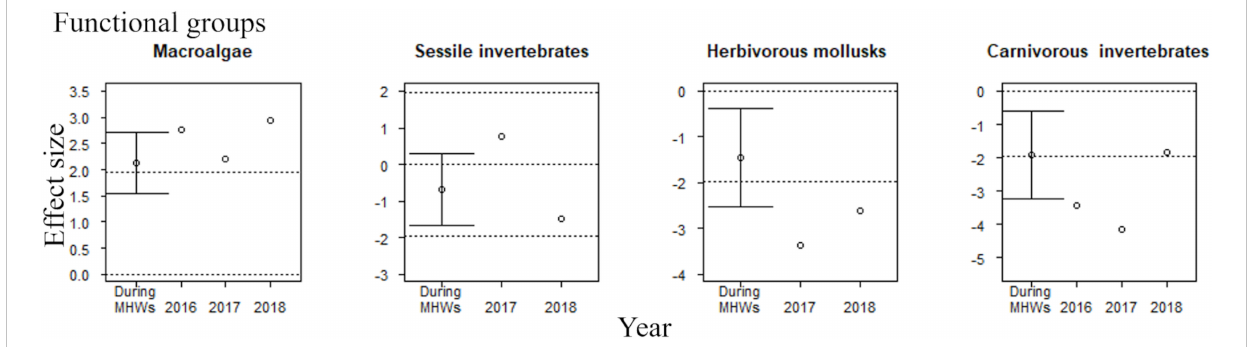
FIGURE 3 Effect sizes of MHWs on the community abundance of four functional groups during the MHWs (2010 – 2016), in the last year of the MHWs (2016; shown only for functional groups where accumulative carryover effects were detected), and in the fi rst (2017) and second (2018) years after the MHWs. The mean ( ± 95% CI) is only presented for effect sizes during the MHWs. An abundance is signi fi cantly different from that before the MHWs if the 95% con fi dence interval does not cross the zero line or if the absolute value of the effect size exceeds 1.96 (where there is no con fi dence interval for the estimated effect size). The dotted lines represent 0 and ±95%